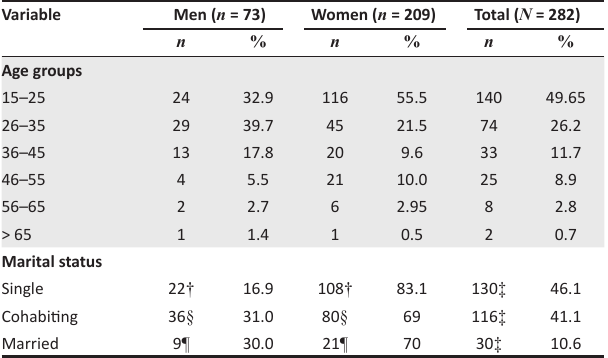
TABLE 1: Age groups of the study population based on